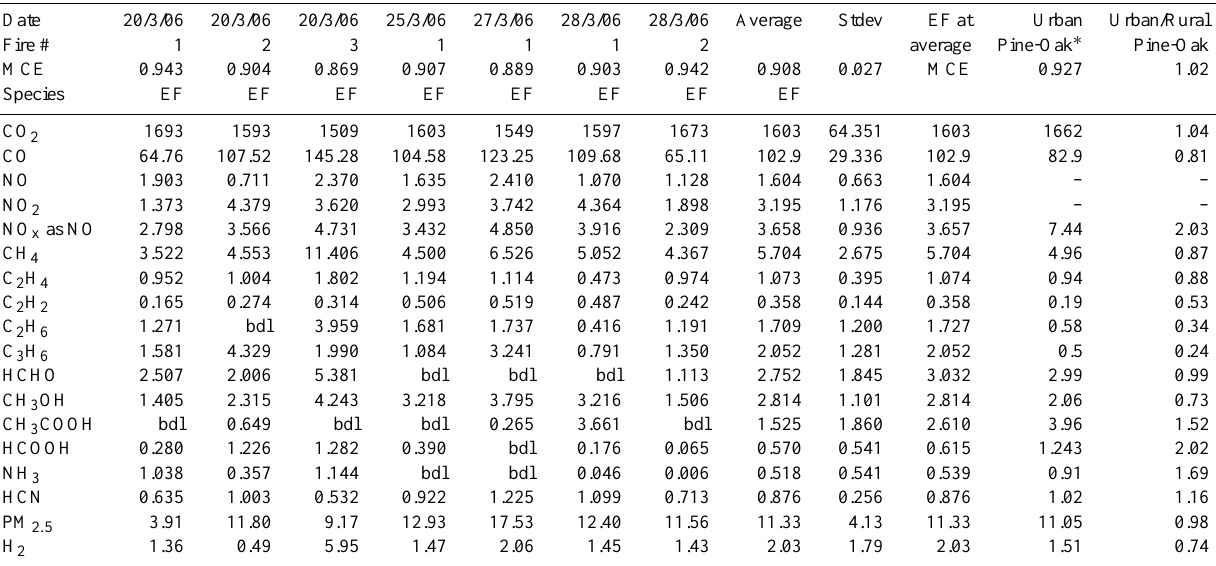
Table 6. Emission factors (EF, gkg − 1 ) and modified combustion efficiency (MCE) measured in rural pine-oak forests in Mexico compared to data from urban-impacted pine-oak forests in